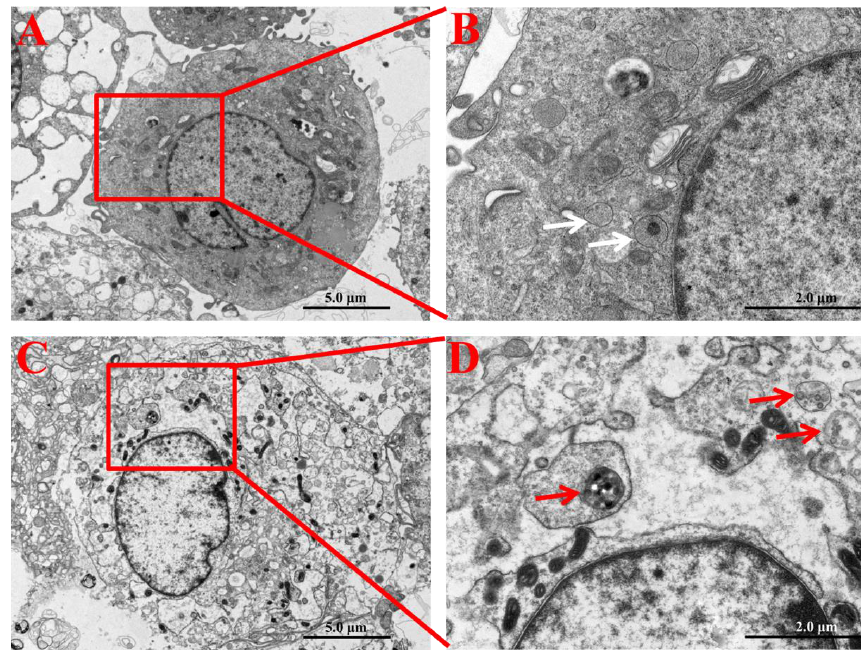
Figure 2. Cellular internalization and localization of SNPs in PLCs. ( A ) TEM image of PLCs in the control group (without SNP exposure). ( B ) Zoomed in image of the red box marked in A. White arrows indicate that vesicles did not include SNPs in granulosa cells. ( C ) TEM image of PLCs exposed to 100 µg/mL SNPs. ( D ) Zoomed in image of the red box in C. Red arrows indicate that vesicles enclosed SNPs in the cytoplasm of granulosa cells. Scale bar, 5.0 µm ( A , C ) and 2.0 µm ( B , D ).